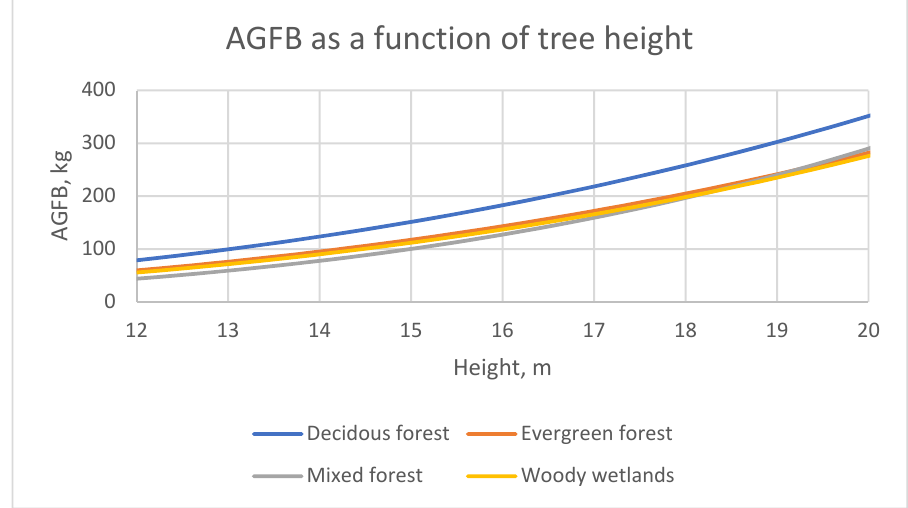
Figure 5. Duplin County: Relationship between tree height and AGFB, by forest type.